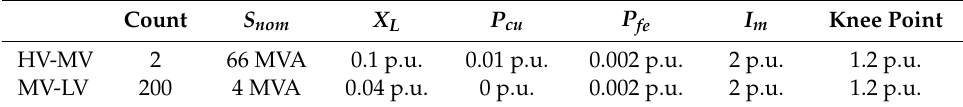
Table 1. Transformer Models.